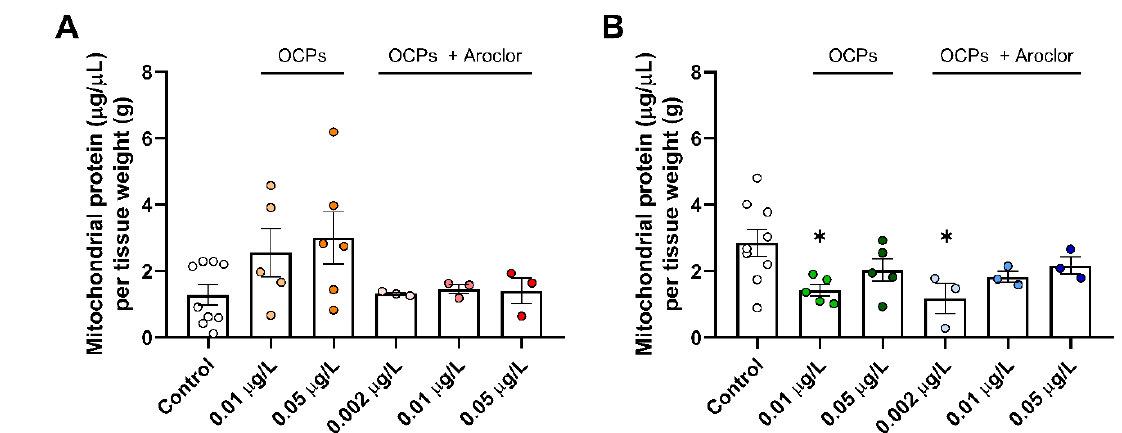
Figure 3. The amounts of mitochondrial proteins in the tails of persistent organic pollutant (POP)-exposed ( A ) female and ( B ) male zebrafish. Mitochondrial protein amounts were normalized according to the weight of the tissue. Control groups are shown as white dots, 0.01 µ g/L organochlorine pesticide (OCP)-exposed females as yellow dots, 0.05 µ g/L OCP-exposed females as orange dots, 0.002 µ g/L OCP-and-Aroclor-exposed females as light pink dots, 0.01 µ g/L OCP-and-Aroclor-exposed females as pink dots, 0.05 µ g/L OCP-and-Aroclor-exposed females as red dots, 0.01 µ g/L OCP-exposed males as green dots, 0.05 µ g/L OCP-exposed males as dark green dots, 0.002 µ g/L OCP-and-Aroclor-exposed males as light blue dots, 0.01 µ g/L OCP-and-Aroclor-exposed males as blue dots, and 0.05 µ g/L OCP-and-Aroclor-exposed males as navy blue dots. Results represent the mean and S.E.M. Statistical analysis was performed using GraphPad Prism 8.0.1 software. One-way analysis of variance was used to compare to the control. * p < 0.05 compared to the control.